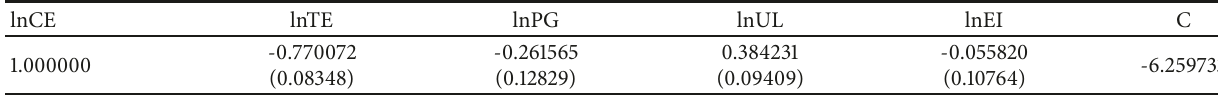
Table 5: Normalized cointegrating coefficients.